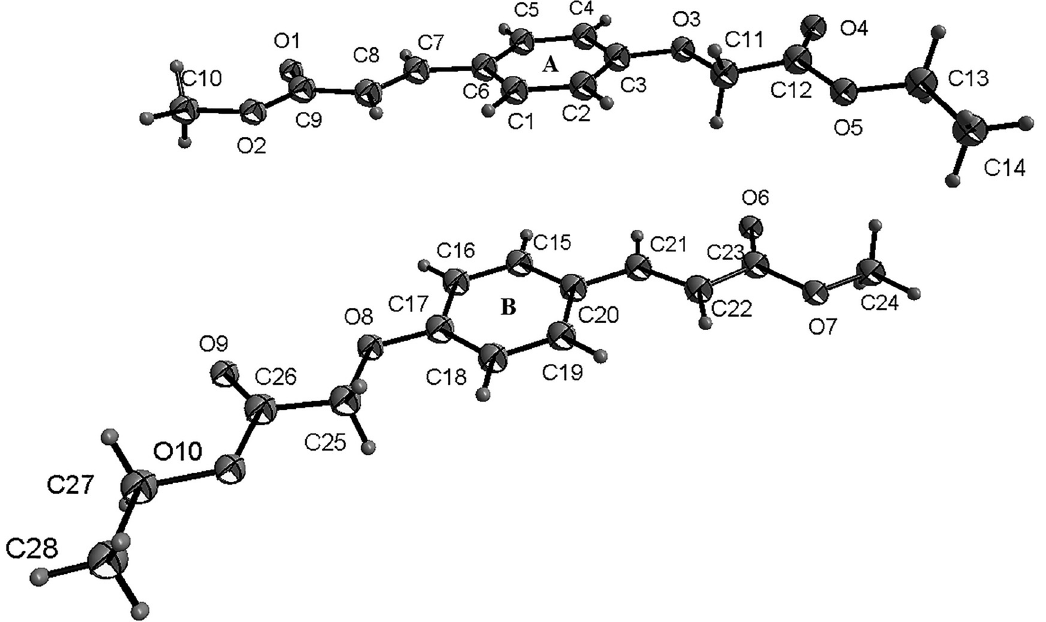
Table  : Data collection and